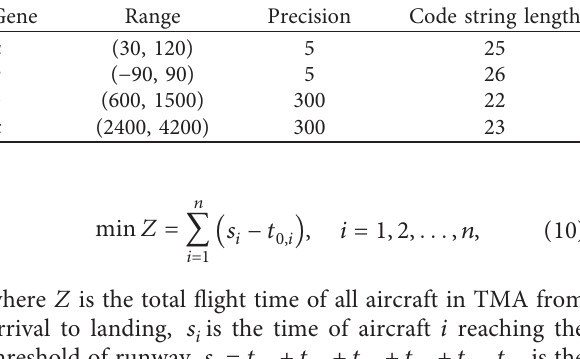
Table 3: Binary coding